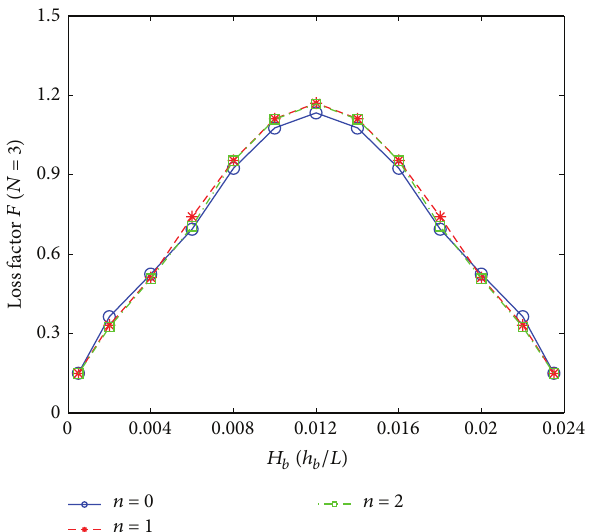
Figure 15: Optimized loss factor results for symmetric and asym- metric CLD configurations ( 𝐻 𝑏 + 𝐻 𝑐 = 0.024 ).